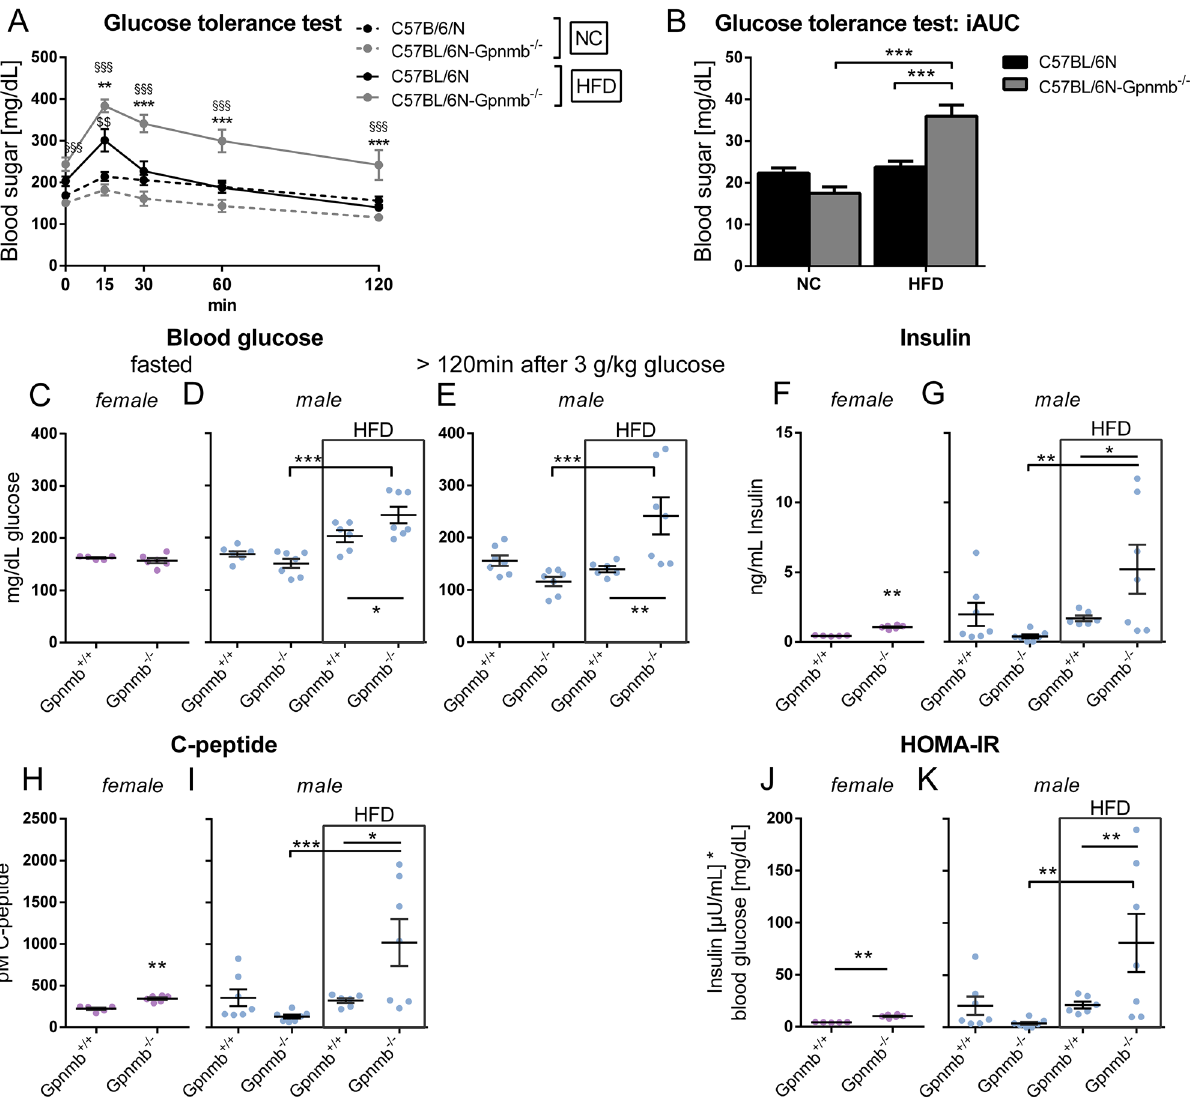
Figure 2. Insulin resistance of lean or HFD-fed Gpnmb -/- and wildtype mice. ( A ) Blood glucose time line of oral glucose tolerance test conducted in 6 h fasted animals and ( B ) its respective integrated area under the curve (iAUC). ( C–E ) Blood glucose of ( A ) in comparison to female control animals. ( F,I ) ELISA of insulin and C-peptide in plasma. ( J–K ) Homeostatic model assessment for insulin resistance (HOMA-IR), a product of insulin and fasted blood sugar. NC: normal chow, HFD: high fat diet. n = 6–7, mean ± SEM. Statistical differences were determined by a non-parametric t-test/Mann Whitney test for female animals ( C , F , H , J ) and by a Two-way ANOVA with Bonferroni post-hoc tests for male animals ( A , B , D , E , G , I , K ). ( A ) * C57BL/6N (16 weeks HFD) vs. C57BL/6N-Gpnmb-/- (16 weeks HFD); $ C57BL/6N (16 weeks HFD) vs. C57BL/6N (NC); § C57BL/6N- Gpnmb-/- (16 weeks HFD) vs. C57BL/6N-Gpnmb-/- (NC). For all graphs: * p < 0.05; **/$$ p < 0.01; ***/§§§ p <